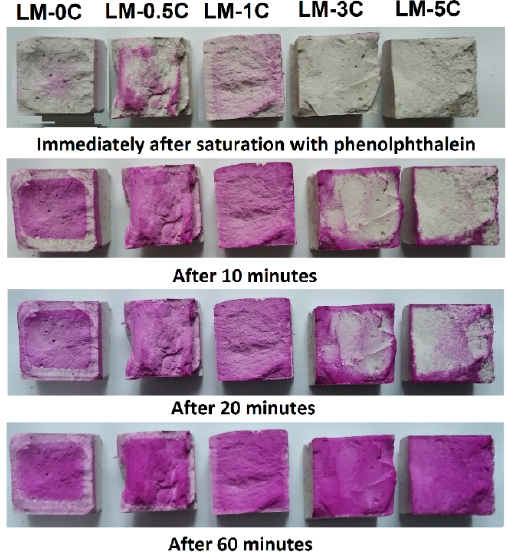
Figure 9. Progress of carbonation of the tested pastes.